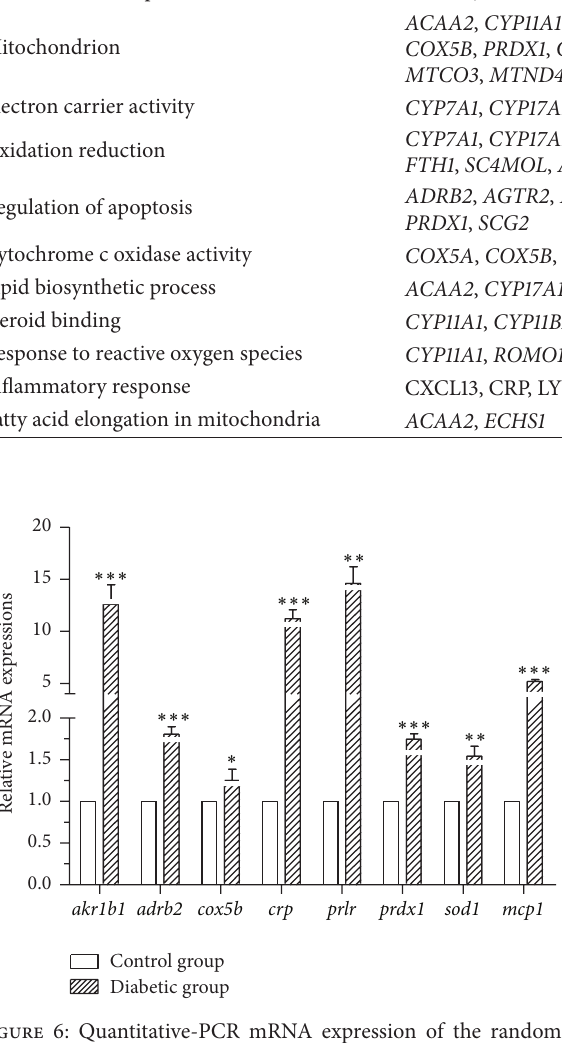
reactive oxygen species response, and inflammatory response were also examined (Table